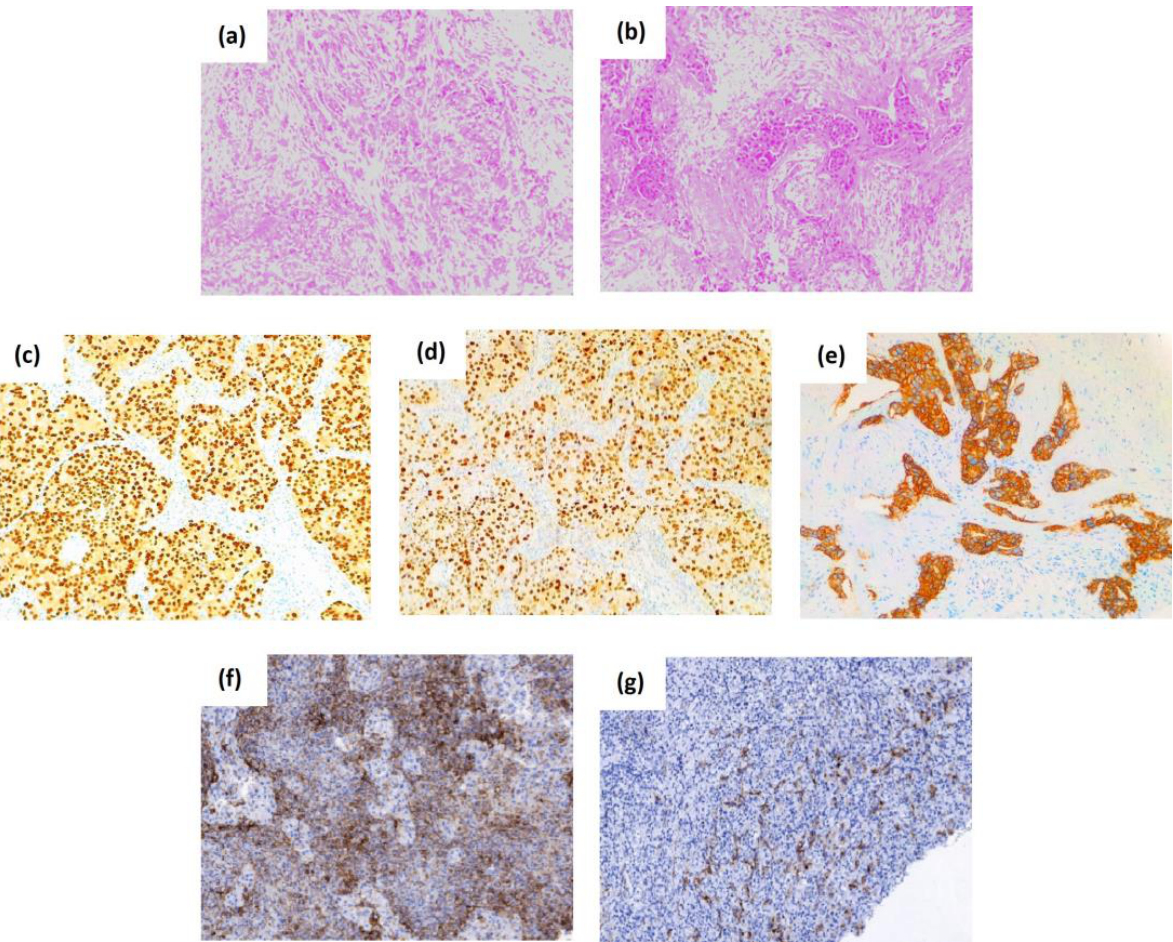
Figure 1. The histological subtypes, common and stem cell-associated markers of breast cancer. The top panel shows representative histological micrographs stained with hematoxylin-eosin of lobular-type ( a ) and ductal-type breast carcinoma ( b ). Representative images of the expression of the first immunohistochemical biomarkers that have laid the foundations for the classification of the BC subtypes, the estrogen receptor ( c ), the progesterone receptor ( d ), and the human epidermal growth factor receptor 2 or HER2 ( e ). The bottom panel shows the expression of the breast cancer stem cell-associated biomarkers CD44 ( f ), and CD133 ( g ). Original magnification 100×.